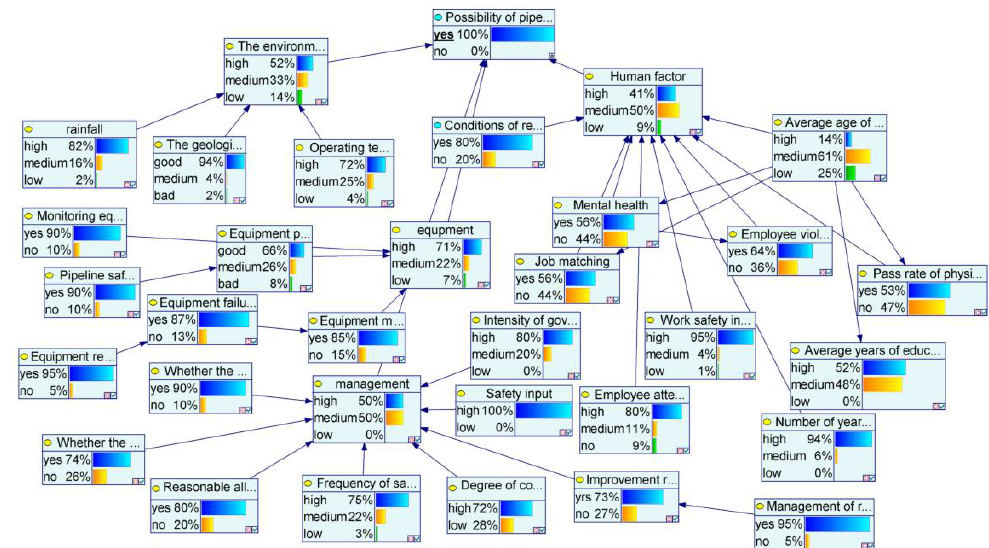
Figure 5. Reverse inference of pipeline third-party damage. Table 6. Posteriori probability of pipeline third-party damage related